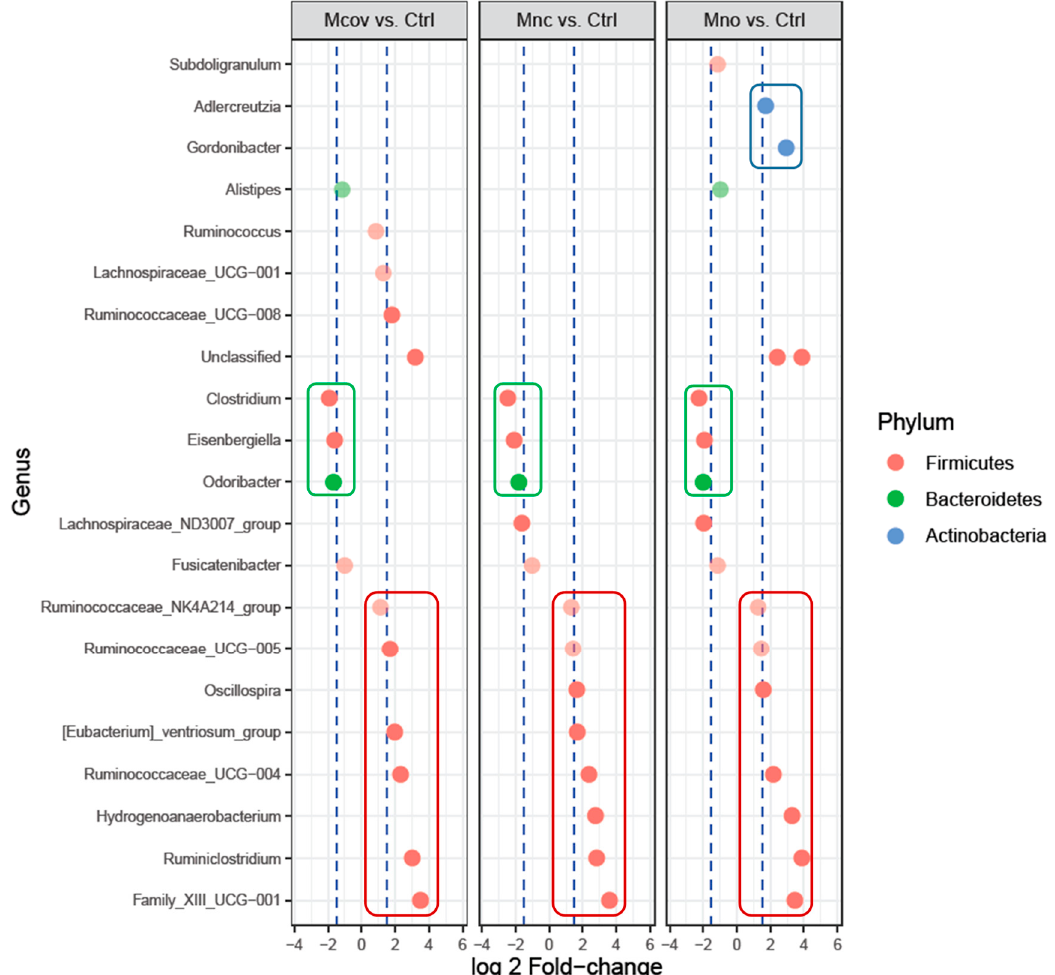
Figure 7. Differential genus abundance analysis between microbiota after fermentation of the apple matrices (Mno, Mnc, Mcov) and initial microbiota (control T0). Log2 Fold-Change relative abundance of 22 differentially abundant genera (adjusted p -value < 0.05). The x-axis and dot colors refer to the genus and phylum assignment, respectively. Genus abundances positively or negatively affected by the 3 matrices were surrounded by red and green circles, respectively, and genera specifically enriched with 1 matrix were surrounded by blue circles.